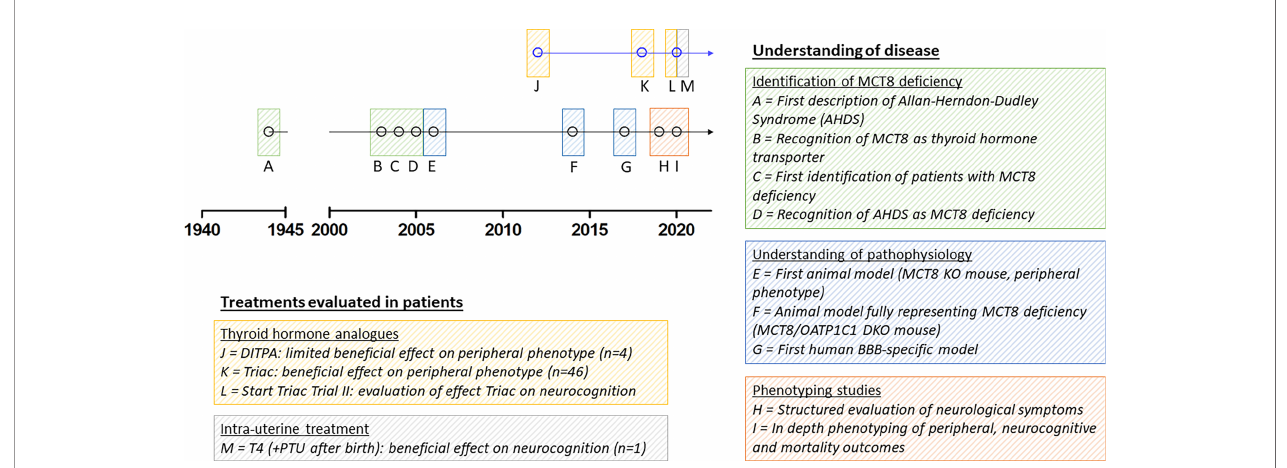
FIGURE 1 | Schematic representation of seminal discoveries in understanding of disease and treatment effects in patients. Due to limited space, we were unable to include all other relevant discoveries on MCT8 de fi ciency in the fi gure. MCT8, monocarboxylate transporter 8; AHDS, Allan-Herndon-Dudley Syndrome; KO, knock- out; OATP1C1, organic anion transporter 1C1; DKO, double knock-out; BBB, blood-brain barrier; DITPA, diiodothyropropionic acid; T4, thyroxine; PTU,